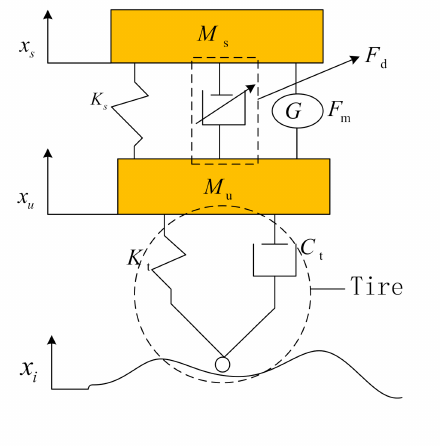
Figure 1. The structure of the 1 / 4 magnetorheological (MR) regenerative suspension system. The explanations of m s , m u , K s , K t , F d , F m , C t , x i , x u , x s are listed in the